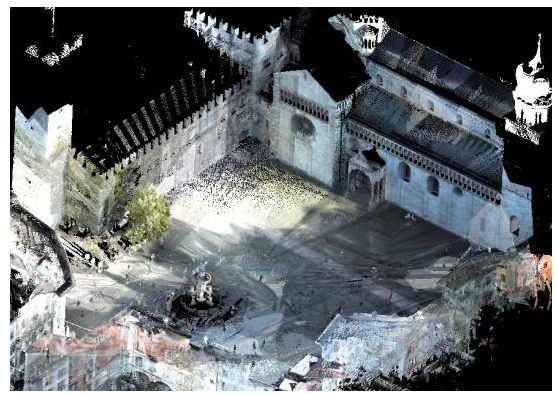
Figure 2. Close-up view of the coloured 3D point cloud collected by MMS in the Duomo square of Trento (Italy).